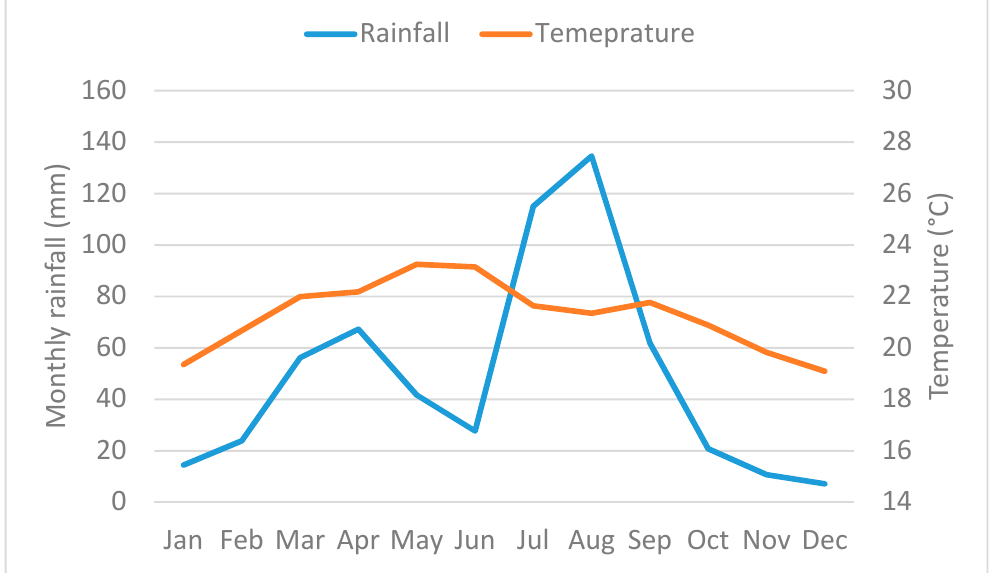
Figure 2. Monthly rainfall distribution and temperature of the Awash basin using CHIRPS and ERA-Interim data, respectively (1981–2005).